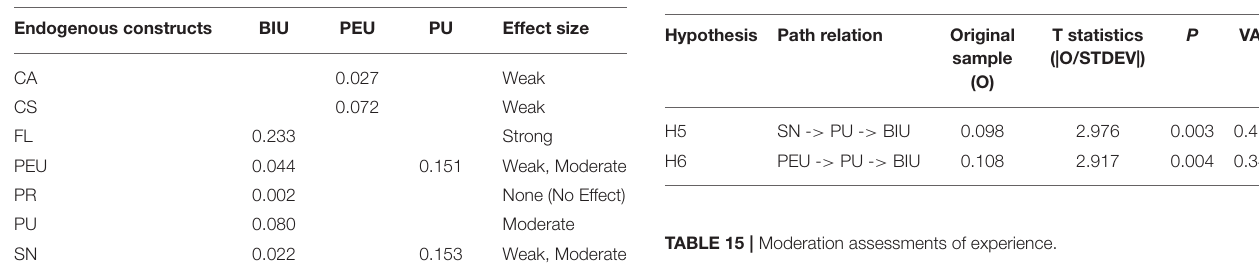
TABLE 10 | Results of effect size (f 2 ).